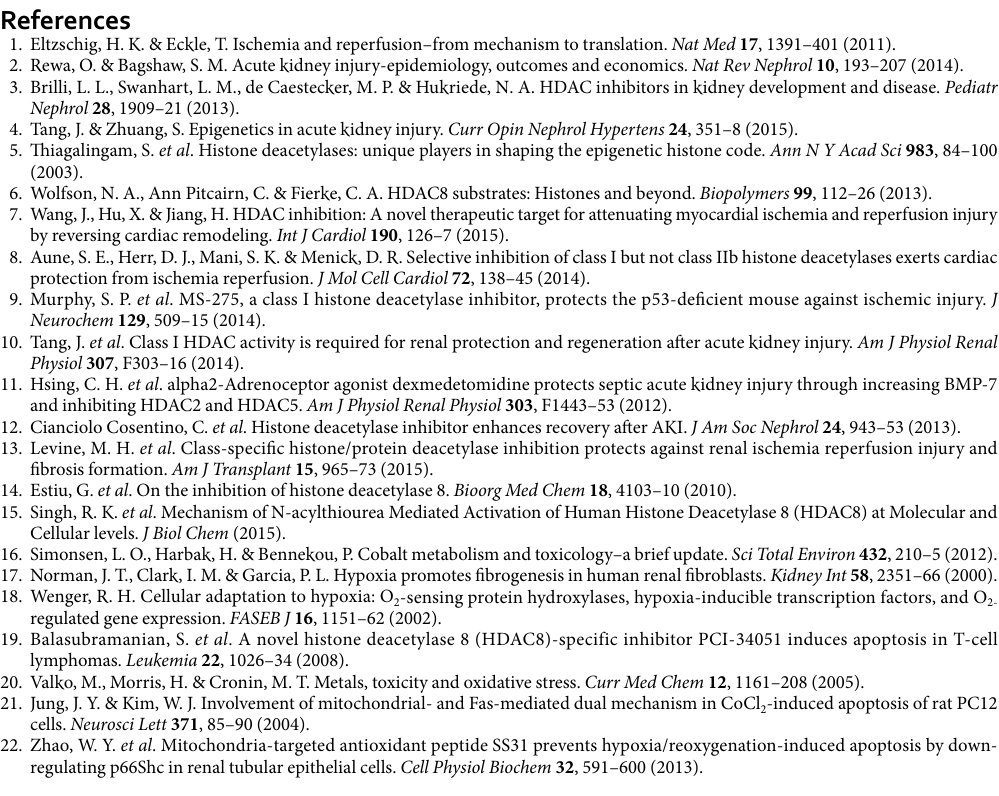
Table 1. Data are presented as percent of enrichment with the precipitated target sequence compared with input DNA. Statistical